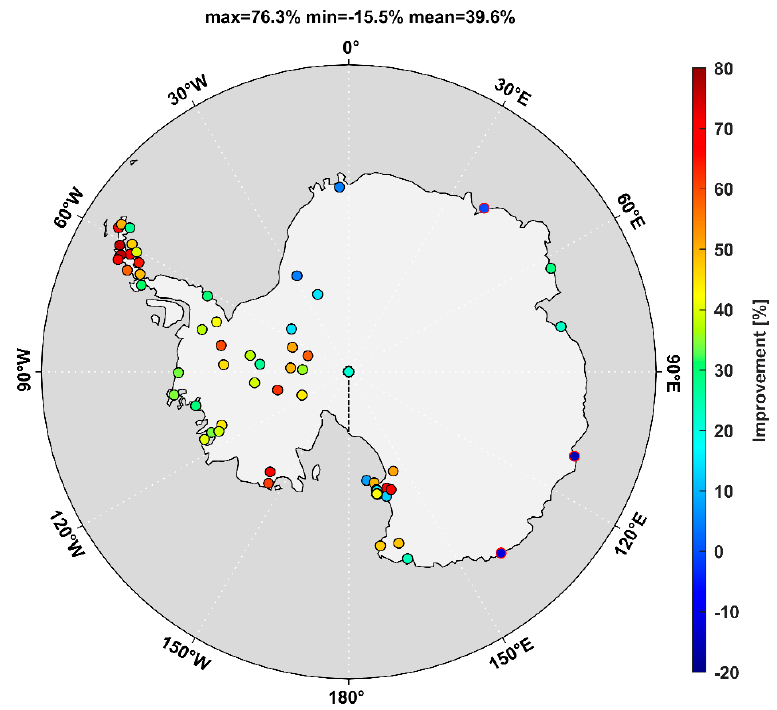
Figure 16. Improvement of LSTM_RBF_ZTD over GPT3_ZTD in forecast period at 65 stations.